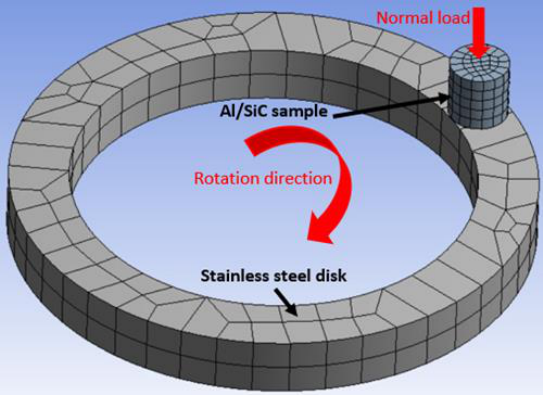
Figure 17. FEM for the frictional process.